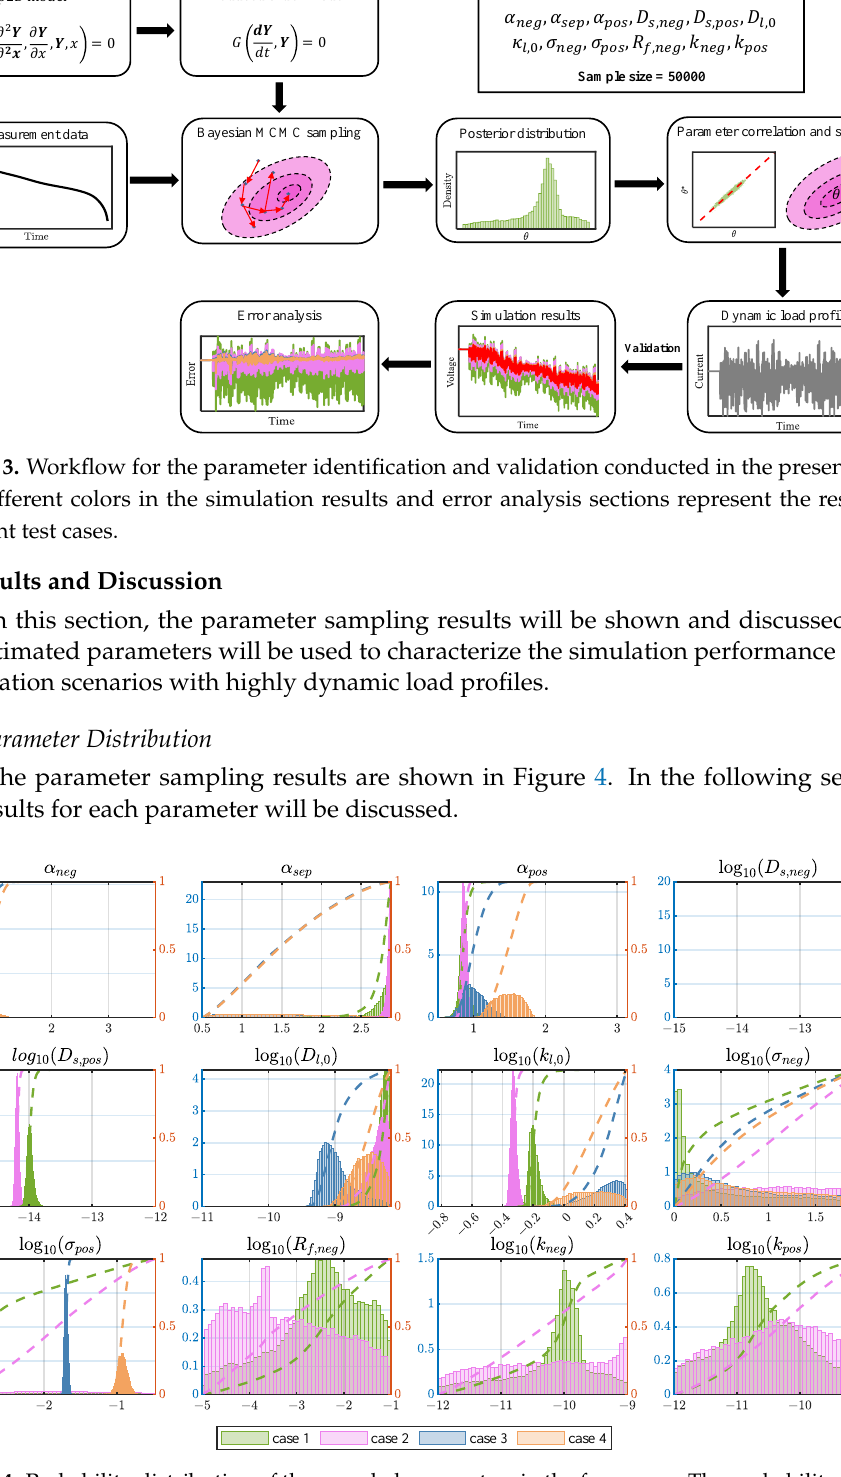
Figure 4. Probability distribution of the sampled parameters in the four cases. The probability density distribution function (PDF) is shown with the histogram and the cumulative distribution function (CDF) for each PDF is shown with a dashed line using the same color as the